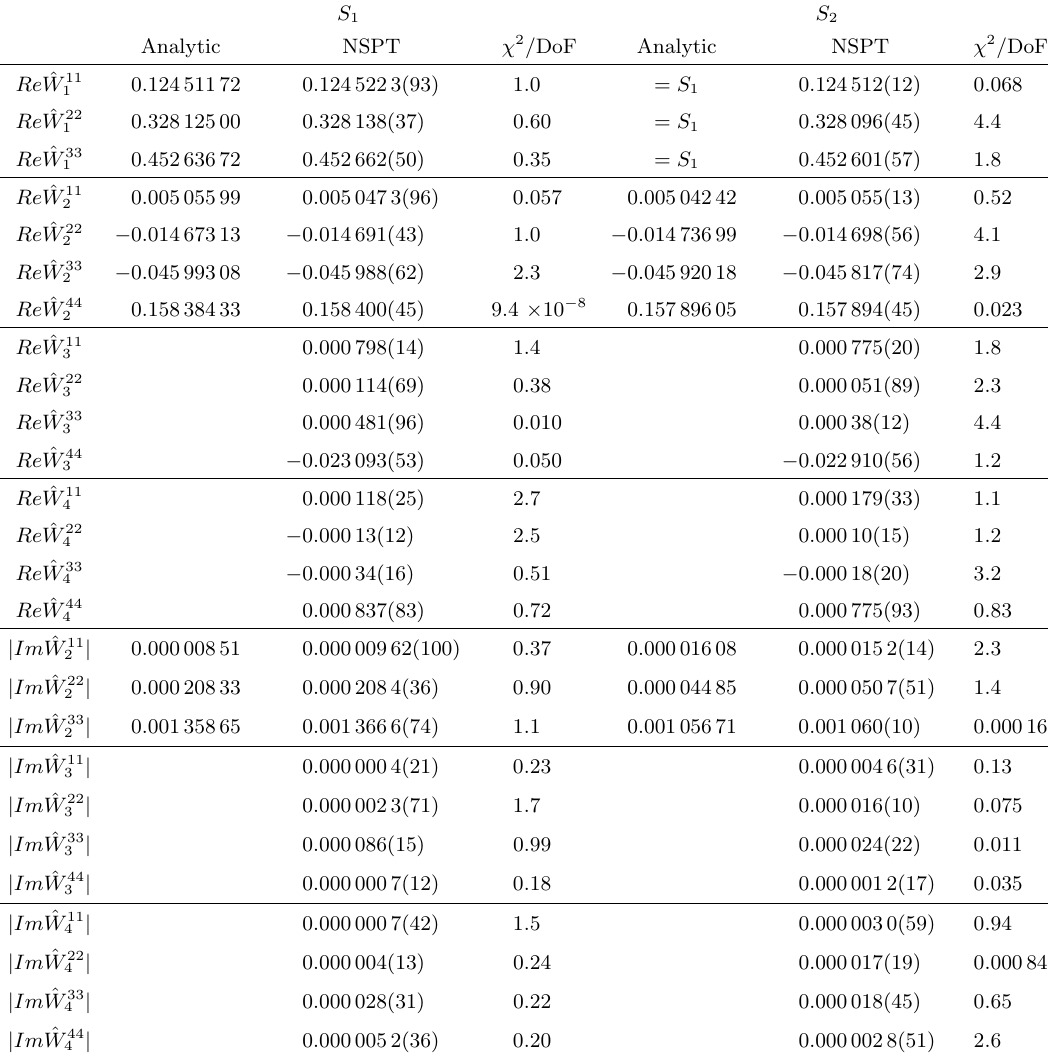
Table 2. Perturbative coe(cid:14)cients for Wilson loops on S 1 ; S 2 planes. (SU(16), k = 1).